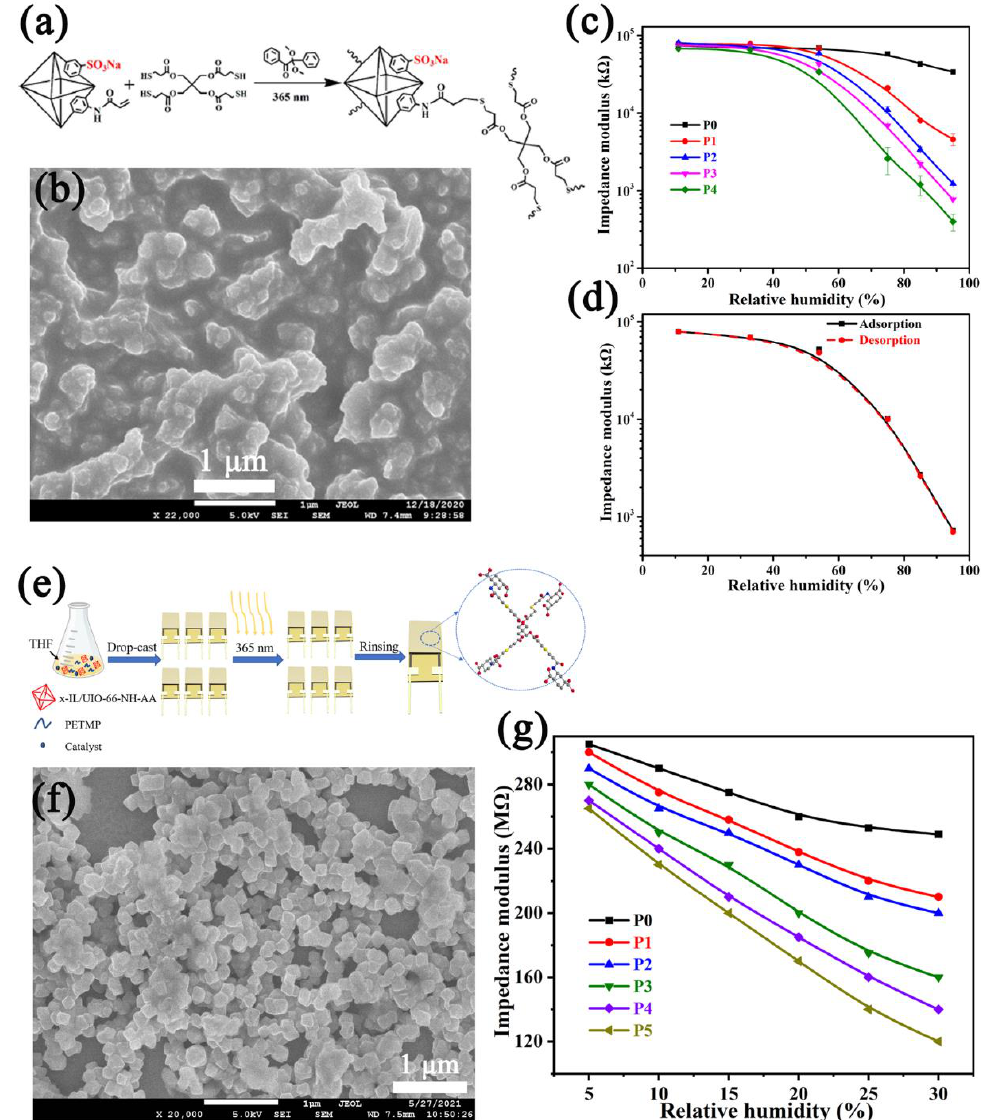
Figure 7. ( a ) Synthetic schematic diagram of alkene − thiol click reaction. ( b ) SEM image of MOF film after click reaction ( scale: 1 μm ). ( c ) Response curves of MOF film − based humidity sensors to humidity in the range of 11 – 95% RH. ( d ) Hysteresis curve of the optimized MOF film − based humidity sensor. Reproduced with permission from Ref. [85]. Copyright 2021, Elsevier B.V. ( e ) Flow chart for preparing MOF − based humidity sensors in batch through in situ click reaction on electrodes. ( f ) SEM image of IL − MOF polyelectrolyte film after click reaction ( scale: 1 μm ). ( g ) Response curves of IL − MOFs polyelectrolyte film − based humidity sensors to low humidity in the range of 5 – 30% RH. Reproduced with permission from Ref. [86]. Copyright 2022, Elsevier.